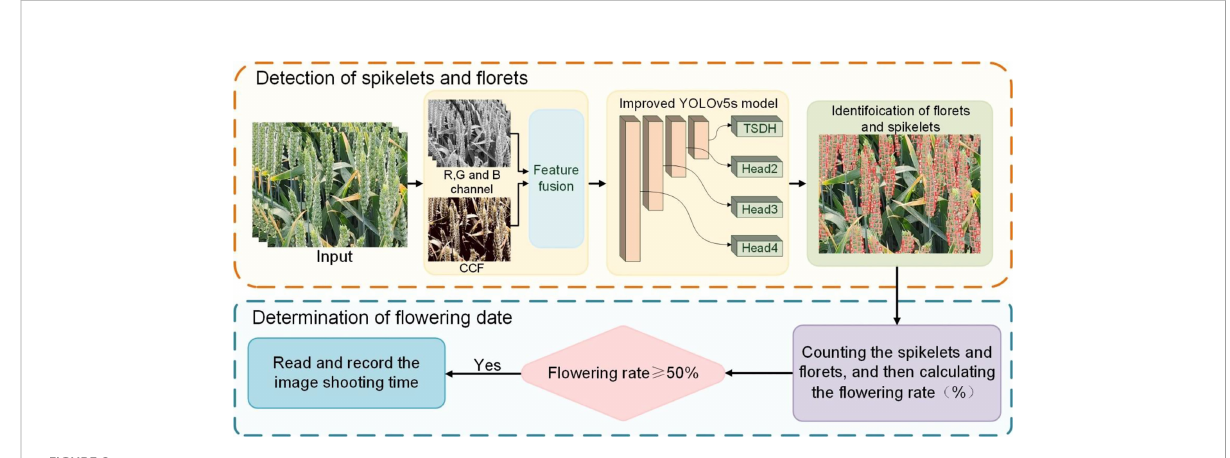
FIGURE 2 Determination process of wheat fl owering